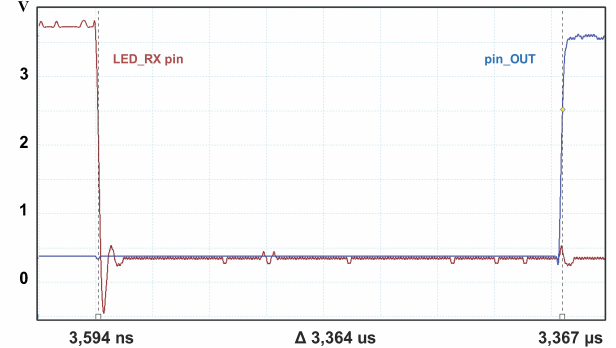
Figure 10. Writing frame capture at 1 Gbps. Frame reception to cryptographic processing end can be seen. Total time from beginning of frame to output is 3.364